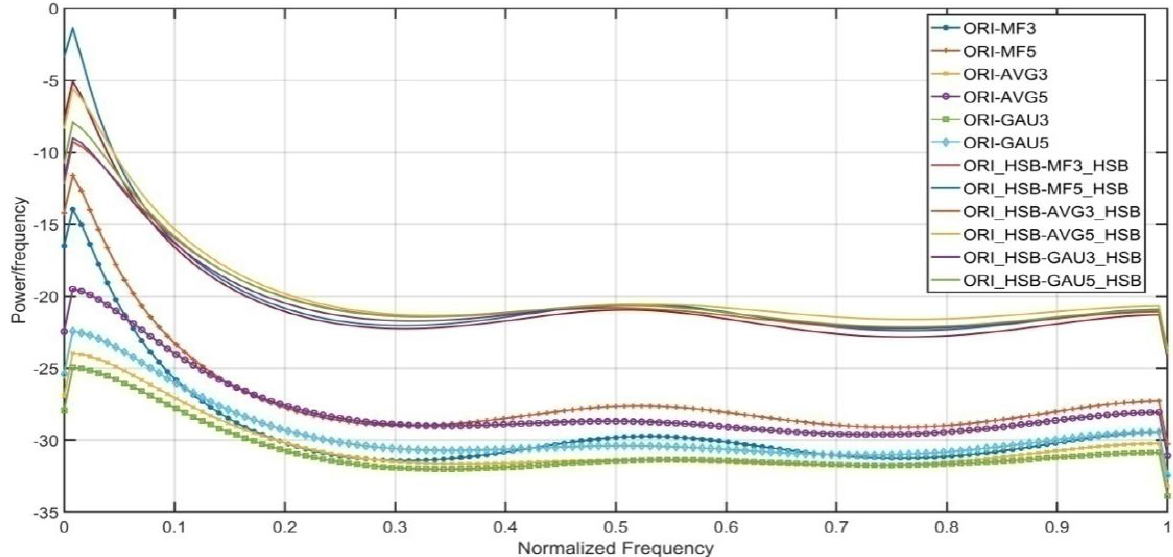
Figure 3. Entropy distribution of non-filtered and filtered difference pairs.